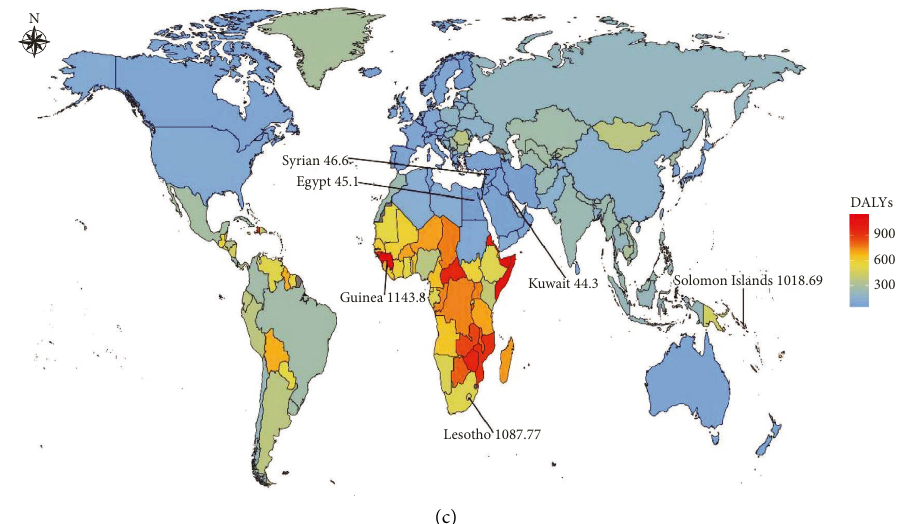
Figure 6: Global disease burden of cervical cancer in 192 countries. (a) The ASDR of cervical cancer in 2019. (b) The ASIR of cervical cancer in 2019. (c) The age-standardized DALY rate of cervical cancer in 2019. ASDR, age-standardized death rate; ASIR, age-standardized incidence